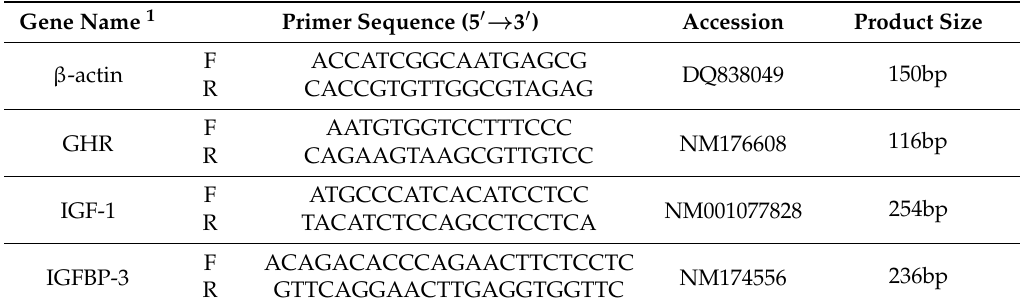
Table 2. Names, primer sequences (F = forward, R = reverse), accession number, product size of candidate